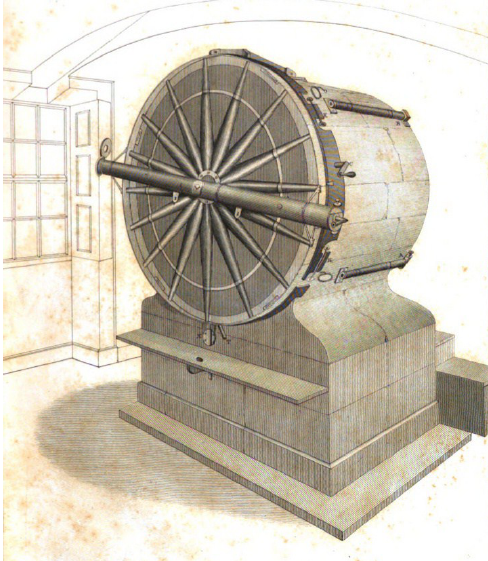
Figure 11: The Troughton Equatorial Telescope